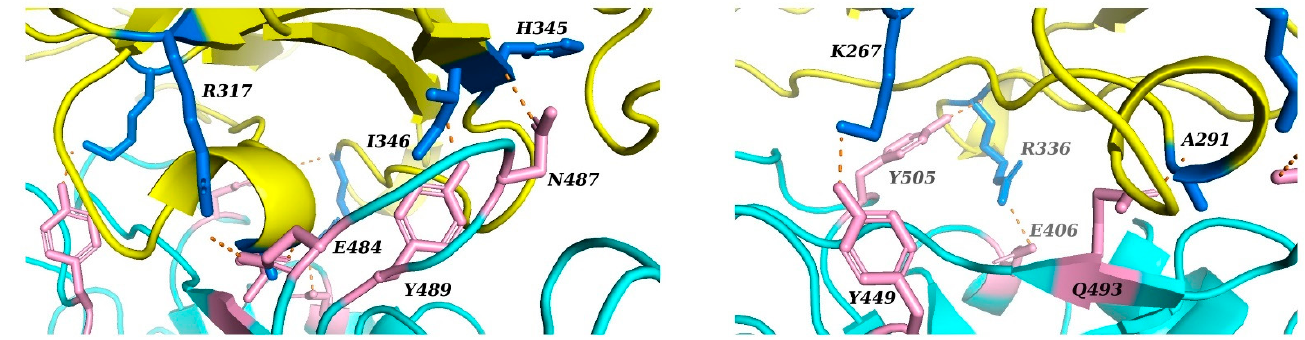
Figure 3. Predicted interactions between the RBD of SARS-CoV-2 and DPP4 obtained using rigid molecular docking with ZDOCK. On the left, the DPP4 amino acid residues R317, I346 and H345 are shown to interact with the SARS-CoV-2 residues E484, Y489 and N487, respectively. On the right, the DPP4 residues K267 and A291 are shown to interact with the SARS-CoV-2 residues Y449 and Q493, respectively. Additionally, R336 of DPP4 interacts with both E406 and Y505 of SARS-CoV-2.